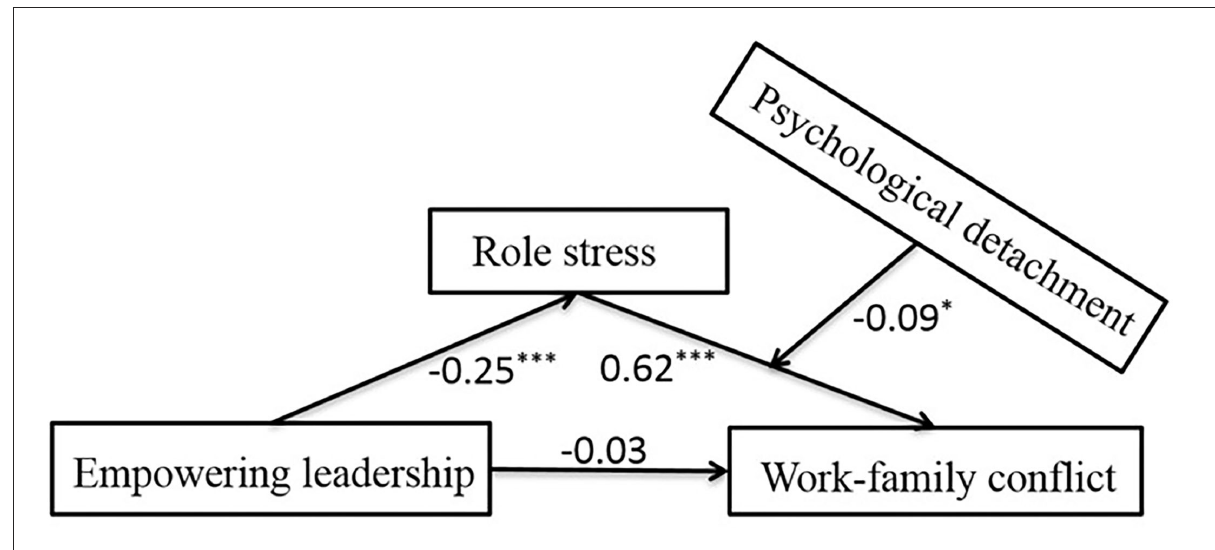
FIGURE2 Path coefficients of the moderated meditation model. *** p < 0.001, * p <